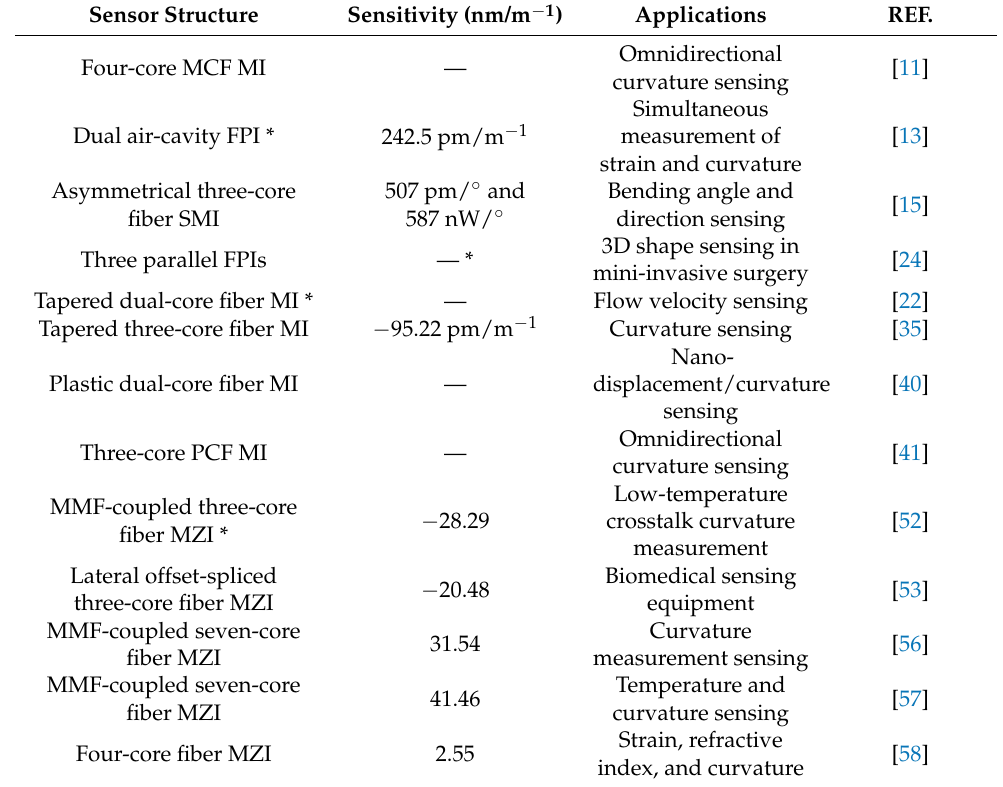
Table 1. Comparison of MCF interferometer-based curvature